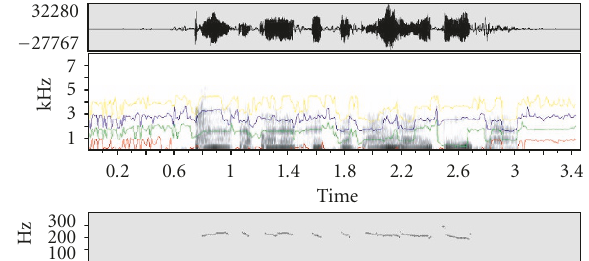
Figure 10: Power spectrum of clean vowel /O/ and Lombard vowel /O/.